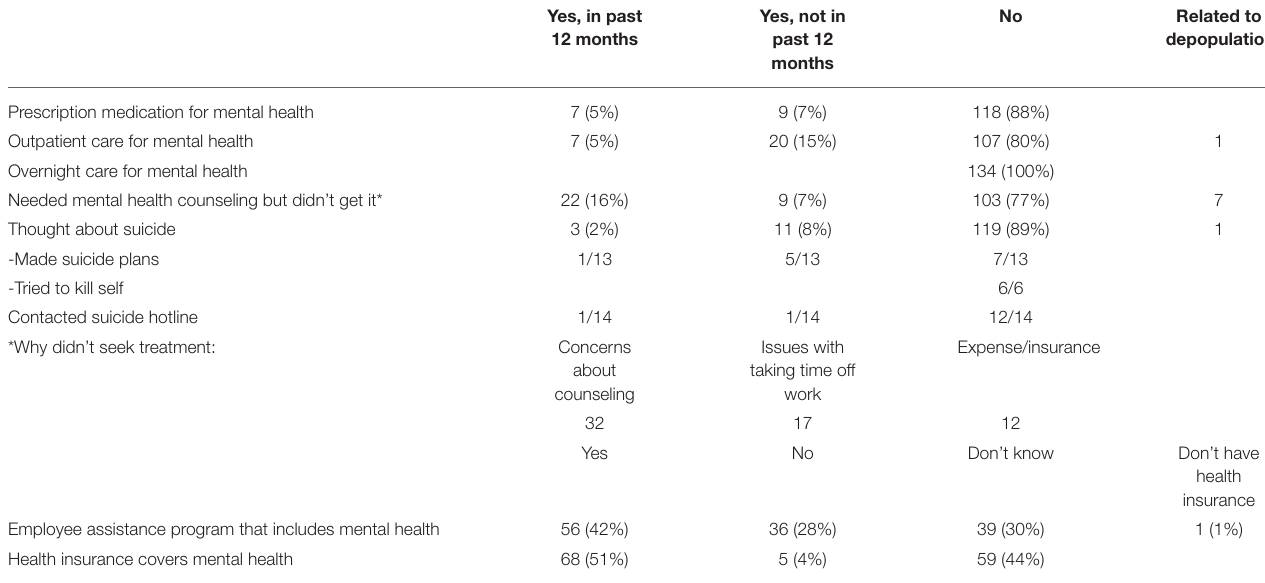
TABLE 3 | Mental health support reported by swine veterinarians ( n = 134).